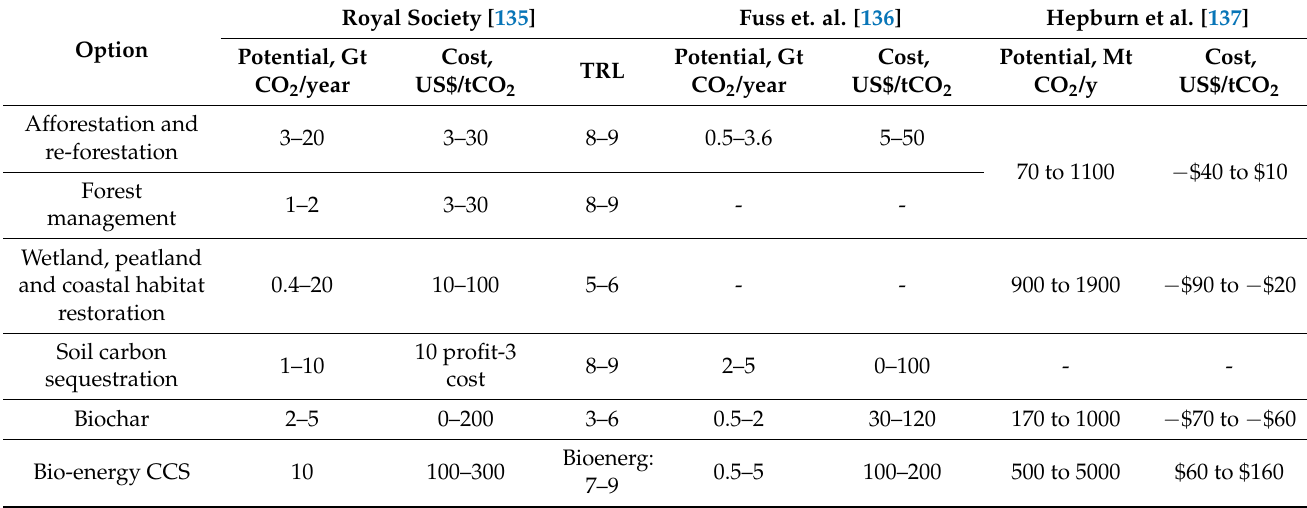
Table 4. Promising options with possible negative carbon